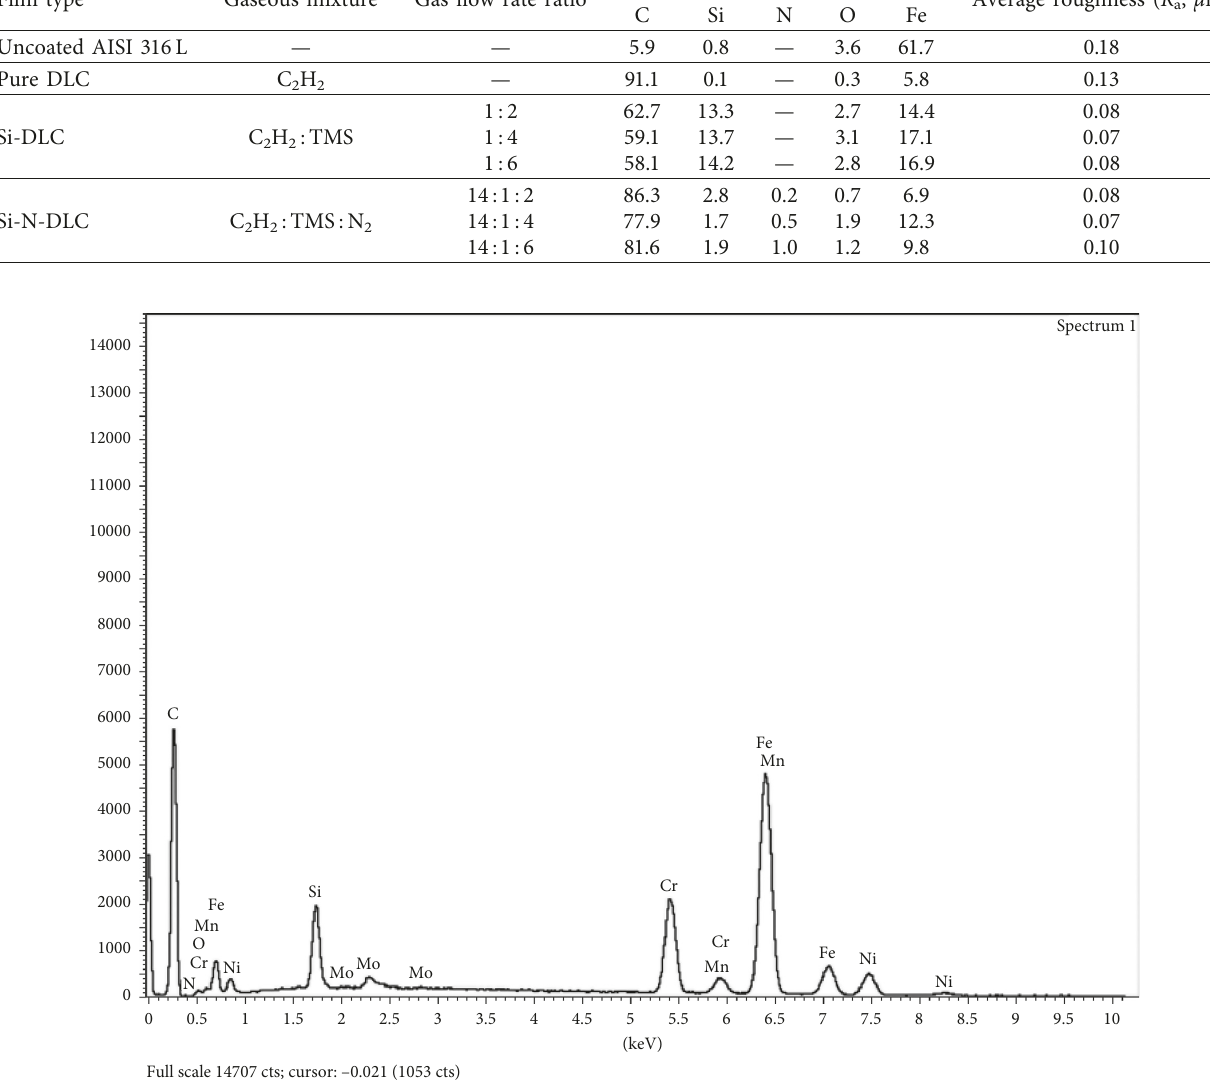
Figure 5: EDS broad spectrum of Si-N-DLC film at a ratio of 14:1: 6.